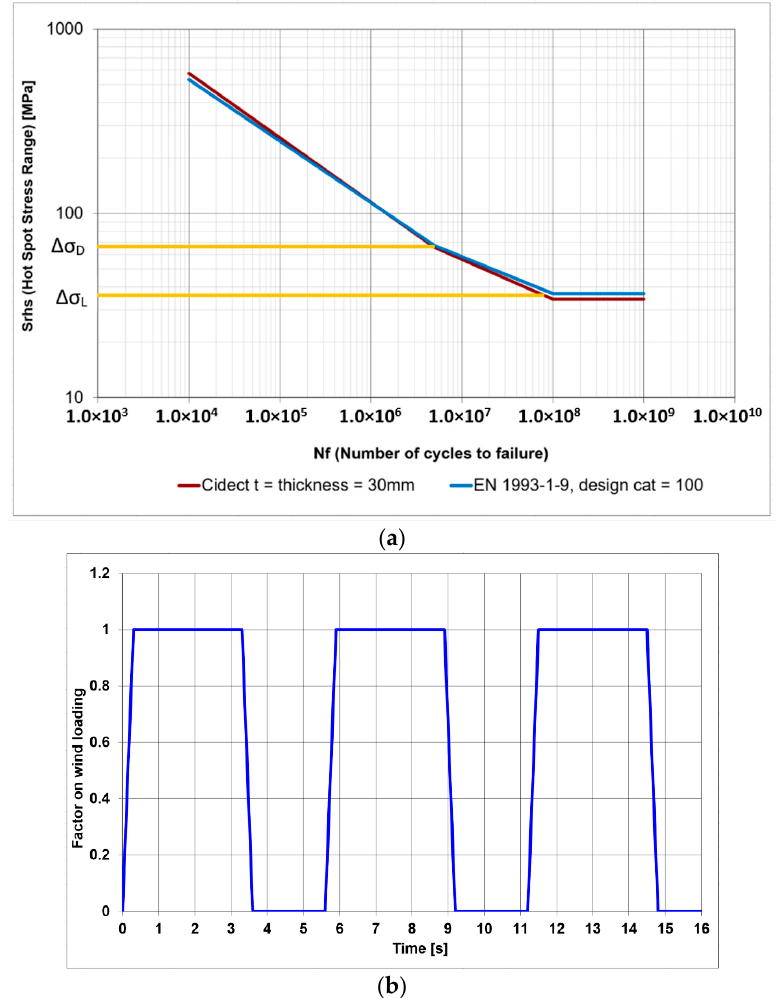
Figure 15. ( a ) Typical S–N curves for fatigue calculation based on the European Standard [47] and Cidect guide [46]; ( b ) transient factors for pulse loading pattern representing wind gust loading.